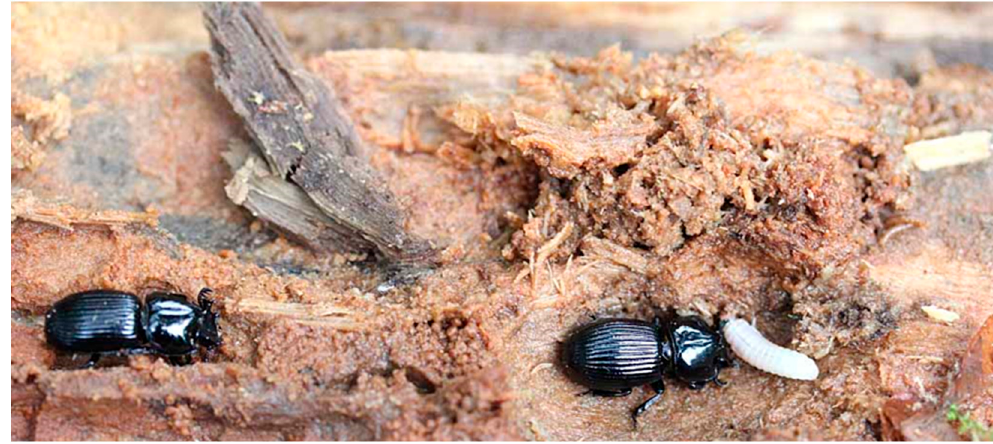
Figure 1. The rotten wood habitat of adult beetles Cylindrocaulus patalis and their larval offspring in the field.